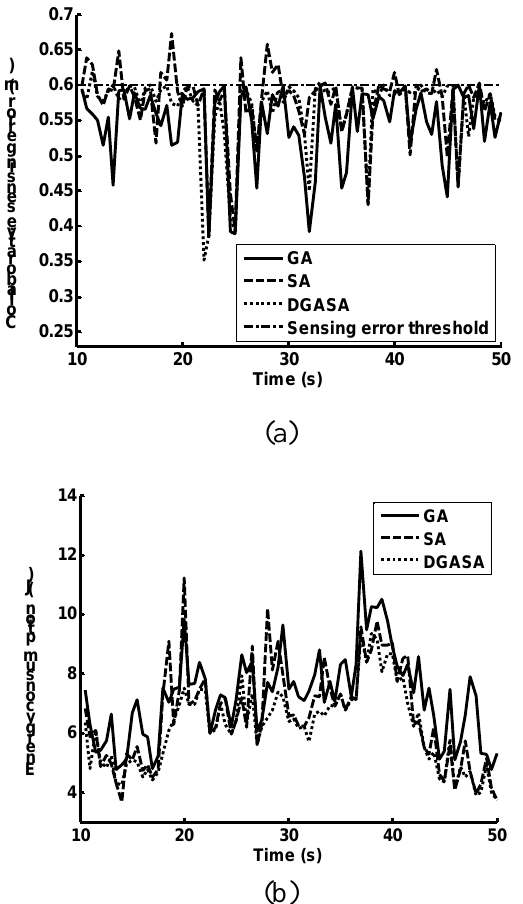
Figure 8. GA, SA and DGASA optimization results: (a) Collaborative sensing error; (b) Energy consumption.